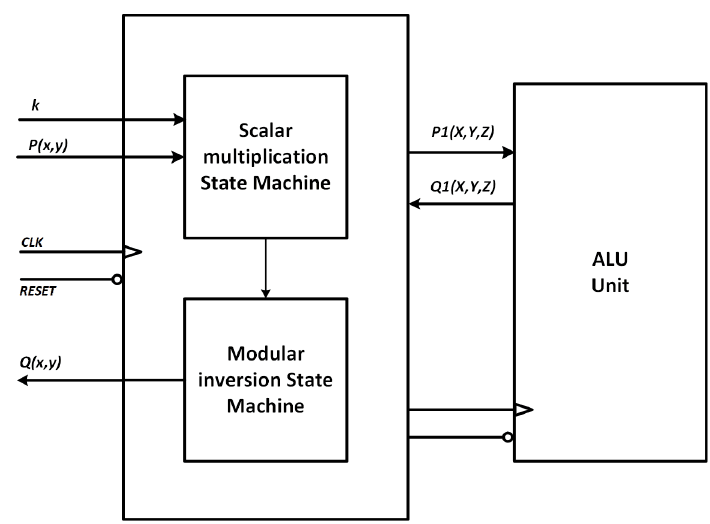
Figure 10. Point multiplication